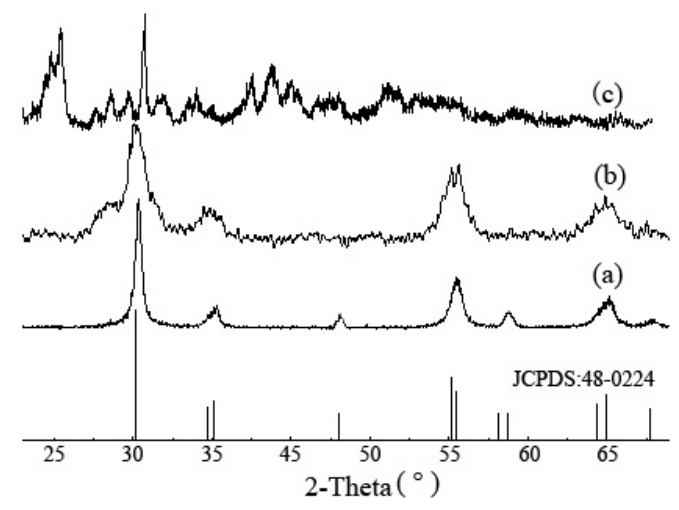
Figure 1. X-ray diffraction patterns of catalysts after thermal treatment at 600 °C. ( a ) 8 mol % yttria-stabilized zirconia (YSZ-8); ( b ) pure ZrO 2 ; ( c ) pure Y 2 O 3 .